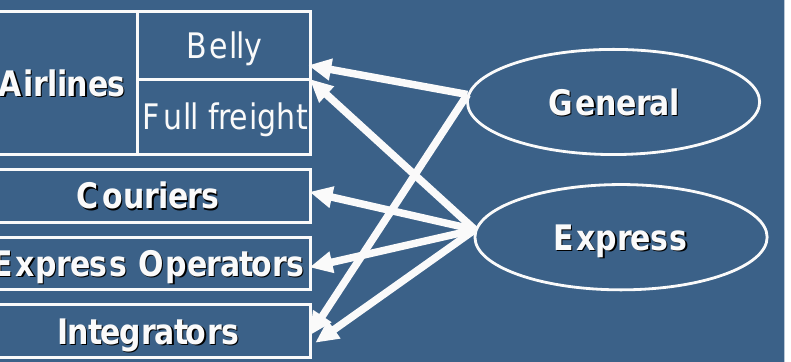
Figure 4. Airfreight, a heterogeneous